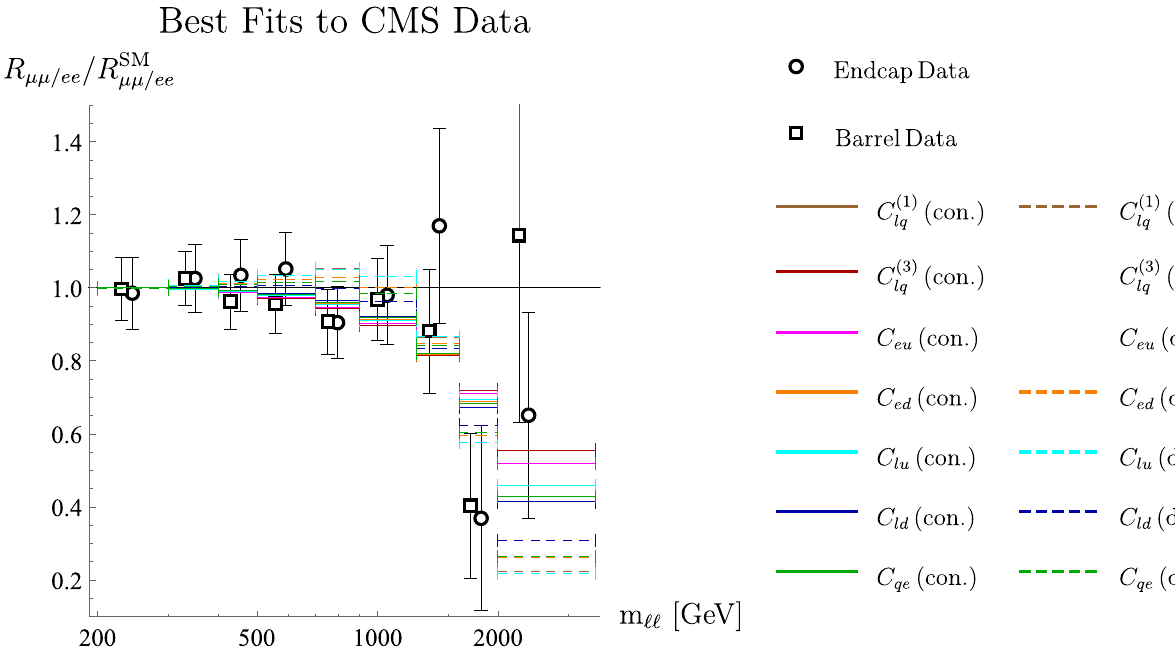
Fig. 7 The double ratio values R μμ/ ee , ij (black circles and squares) together with the best fit curves for different 2-quark–2-lepton operator scenarios (coloured lines) Table 3 Wilson coefficient values ( × 10 − 3 TeV − 2 ) that are preferred (excluded) by the CMS (ATLAS) pp → e + e − measurements. For CMS we state the 1 σ ranges as well